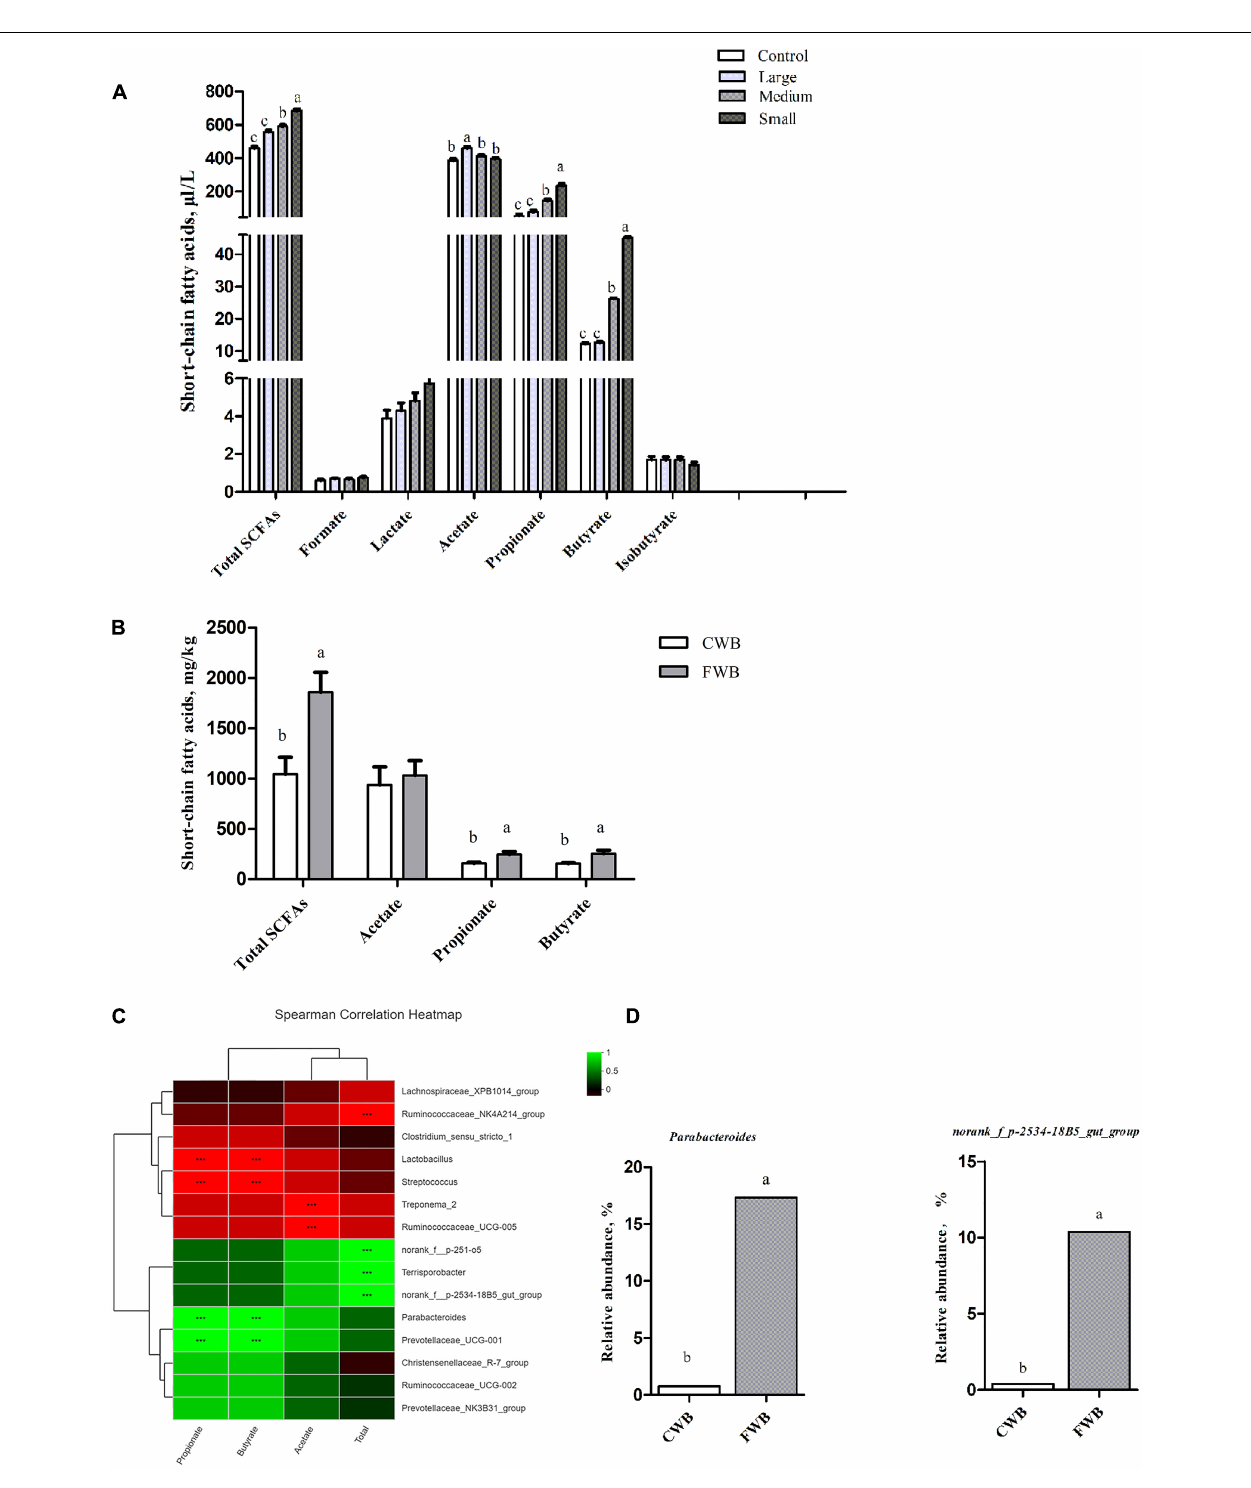
FIGURE 5 | Content of SCFAs in vitro fermentation and in maternal feces, correlation heatmap of the 15 most abundant genera and SCFAs in maternal feces. (A) Content of SCFAs in vitro fermentation. (B) Concentrations of SCFAs in maternal feces. (C) X and Y axes present SCFAs and genus, respectively. The correlation coefficients (R) are shown in different colors on the right side of the legend. *0.01 < p ≤ 0.05, **0.001 < P ≤ 0.01, *** P ≤ 0.001. (D) The relative abundance of SCFA-related microbiota in two groups on the genus level. Control, no ground wheat bran; Large, wheat bran ground through a 2.0-mm sieve; Medium, wheat bran ground through a 1.5-mm sieve; Small, wheat bran ground through a 1.0-mm sieve; CWB, a diet containing coarse wheat bran, with particle size of 605 µ m; FWB, a diet containing fine wheat bran, with particle size of 438 µ m. Values are presented as mean ± SEM ( n = 6). a , b Means without common letters differ at p < 0.05.